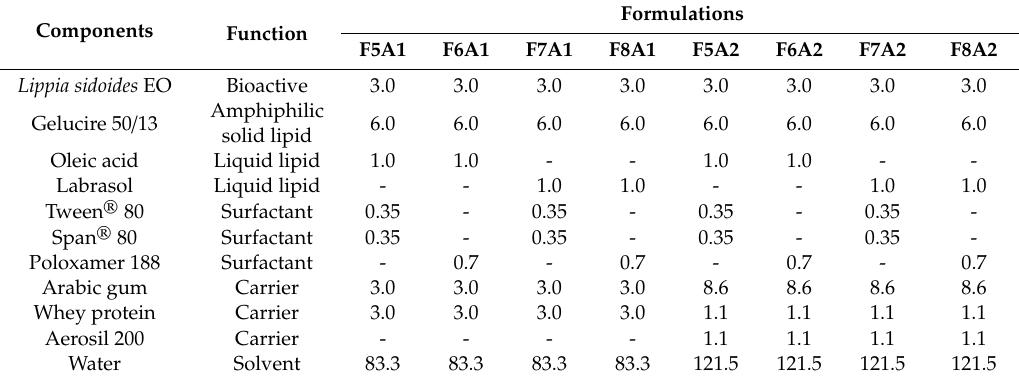
Table 1. Constituents of nanostructured lipid carriers (NLCs) (%, w / w